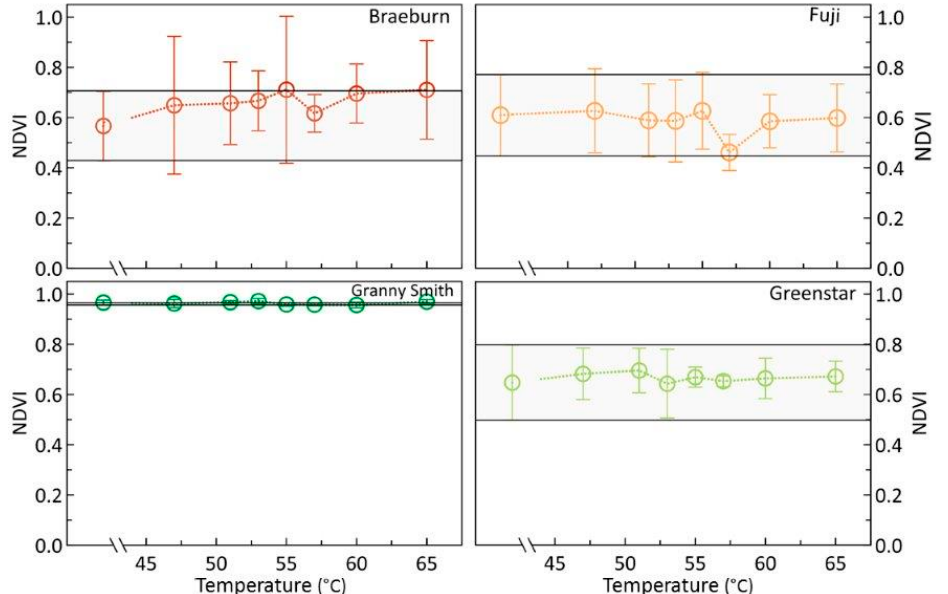
Figure 6. Means of the Normalized Difference Vegetation Index (NDVI) of ‘Braeburn’, ‘Fuji’, ‘Granny Smith’, and ‘Greenstar’ apples, hot ‐ water ‐ treated in the temperature range of 46 to 65 °C for 30 s. The light ‐ grey horizontal bars indicate the standard deviation of results of the respective controls on day one of the experiment, roughly reflecting initial mean parameter variability.